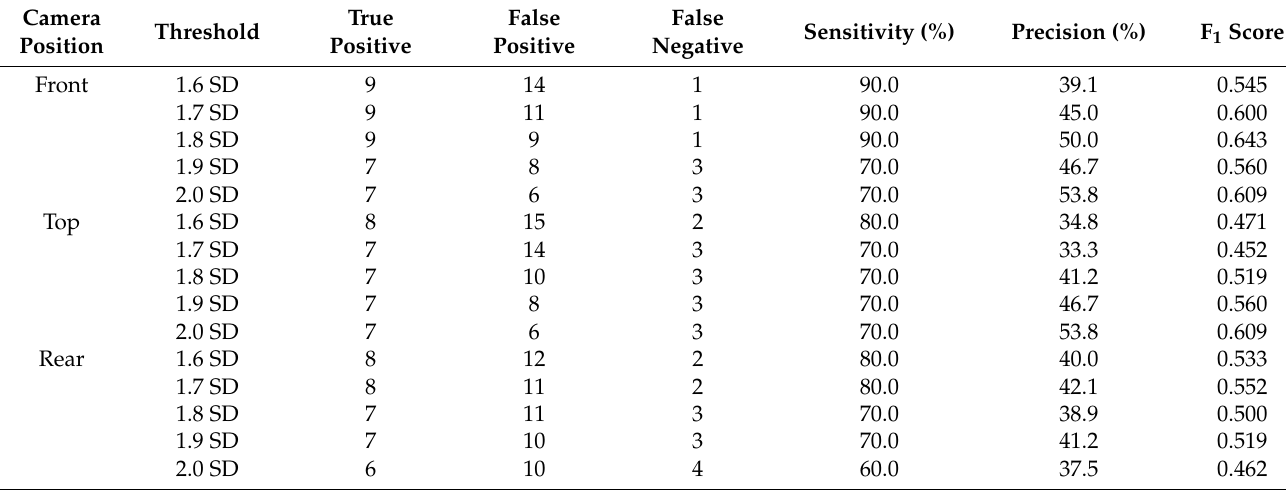
Table 1. Estrus detection performance based on background-subtracted pixel